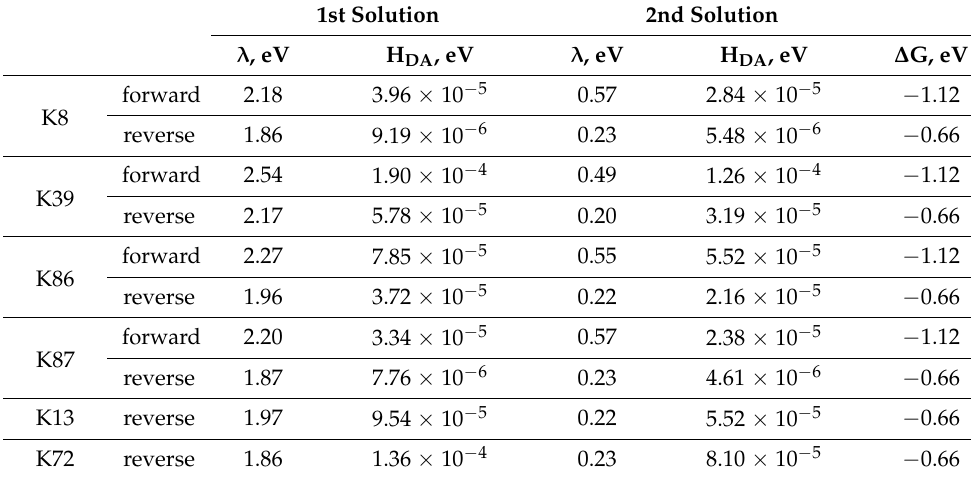
Figure 4. Kinetics of electron transfer measured at 7 different temperatures as Δ A 550 - Δ A 562 with TUPS covalently bound to K8 ( A ) or K13 ( C ); only one of the electron transfer steps is resolved for the “fast” K13-TUPS sample. Single exponential fit to the rising and decaying phases (only one exponential for K13-TUPS) yielded apparent rate coefficients in ( B , D ) (symbols), with fit to Equation (5) as lines. Table 1. Experimentally determined reorganization energies and electronic coupling terms for the electron transfer between TUPS and the heme in cytochrome c -TUPS